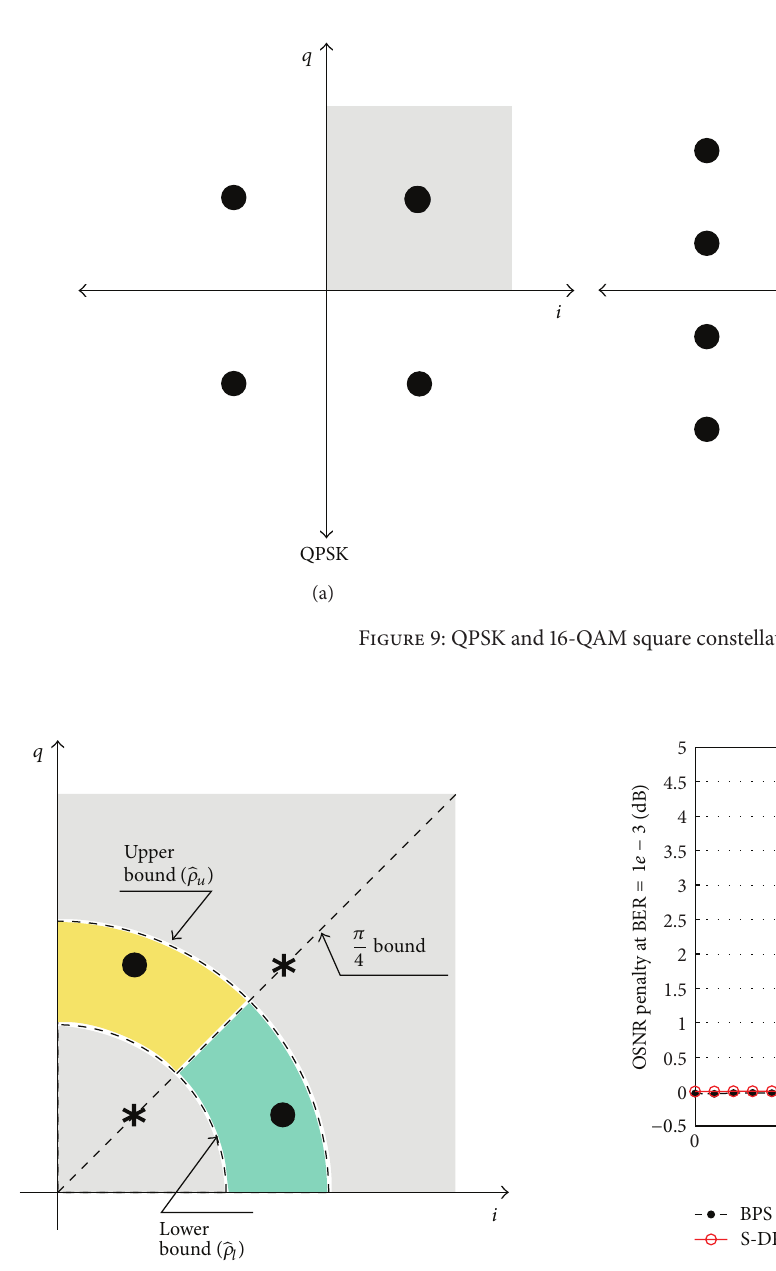
Figure 11: Performance of the proposed S-DPLL + BPS carrier re- covery scheme versus the frequency deviation amplitude ( 𝐴 𝑝 ) for = 35 KHz, 1/𝑇 = 32 Gs/s, Δ ] = 250 KHz, 𝑁 = 21 , and 𝐵 = 32 Δ𝑓 𝑐